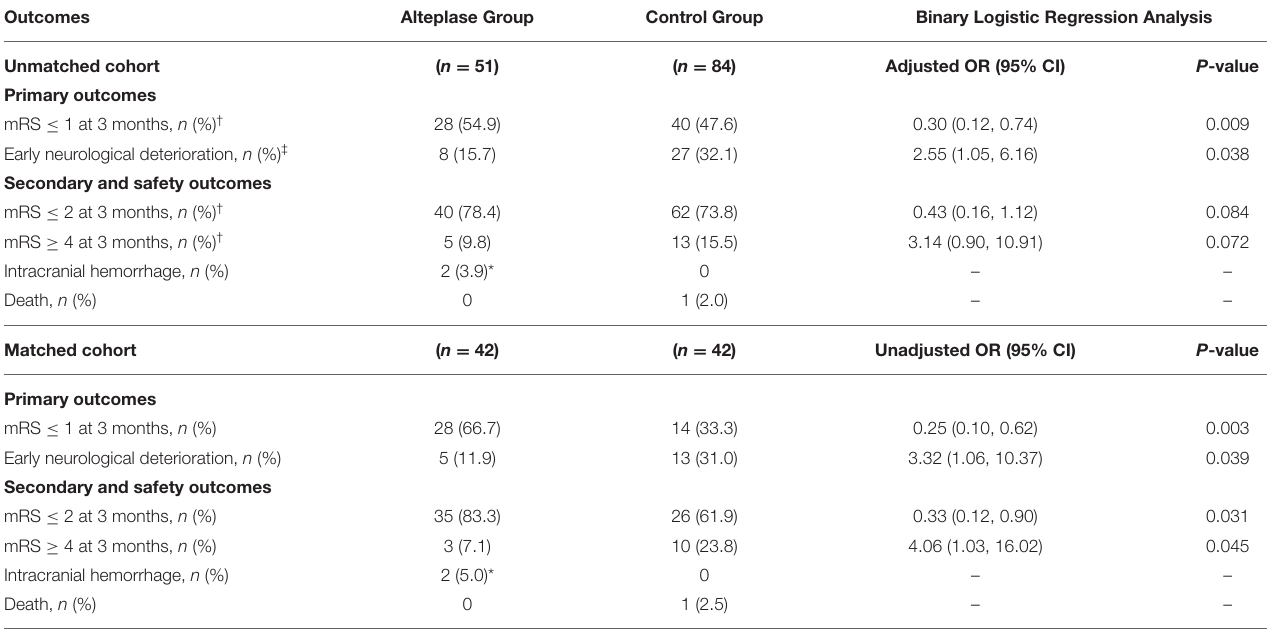
TABLE 2 | Study outcomes.